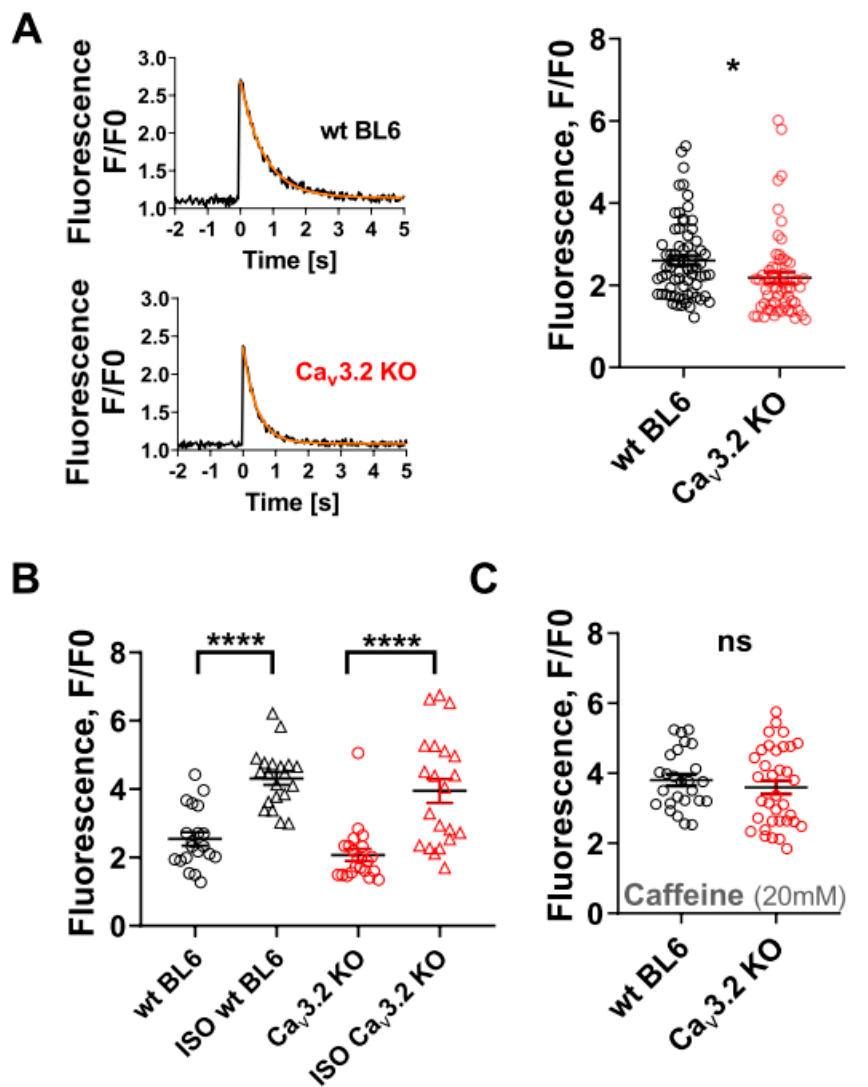
Figure 4. Electrically induced and caffeine-induced intracellular Ca transients in wt and Cav3.2 KO ventricular cardiomyocytes. ( A ) Left: Representative time courses of Fluo-4 fluorescence reporting rises in cytosolic Ca concentration during electrical field stimulation at 0.1 Hz frequency in a single wt and Cav3.2 KO myocyte. The orange lines represent fits of the data with a single exponential function. Right: Comparison of mean Ca peak fluorescence relative to baseline (F/F0) between wt and Cav3.2 KO myocytes. Each data point represents a single cell, and values are expressed as means ± SEM (n = 68 for wt and 59 for Cav3.2 KO myocytes). * p < 0.05 (0.02); unpaired Student’s t -test. The Ca transients decayed with time constants of 0.30 ± 0.02 s in wt and 0.25 ± 0.01 s in Cav3.2 KO myocytes, which were significantly different ( p = 0.04). ( B ) Comparison of mean Ca peak fluorescence (F/F0) before and after the application of 100 nM ISO in wt (n = 20) and Cav3.2 KO (n = 21) myocytes. **** p < 0.0001 (paired Student’s t -test). There was no significant difference between wt and Cav3.2 KO in the presence of ISO ( p = 0.37; unpaired Student’s t -test). The Ca transients under ISO decayed with time constants of 0.14 ± 0.02 s in wt and 0.11 ± 0.02 s in Cav3.2 KO myocytes (not significantly different, p = 0.19). ( C ) Comparison of mean Ca peak fluorescence elicited by an application of 20 mM caffeine, relative to baseline (F/F0), between wt (n = 26) and Cav3.2 KO (n = 35) myocytes. ns—not significant (unpaired Student’s t -test, p =